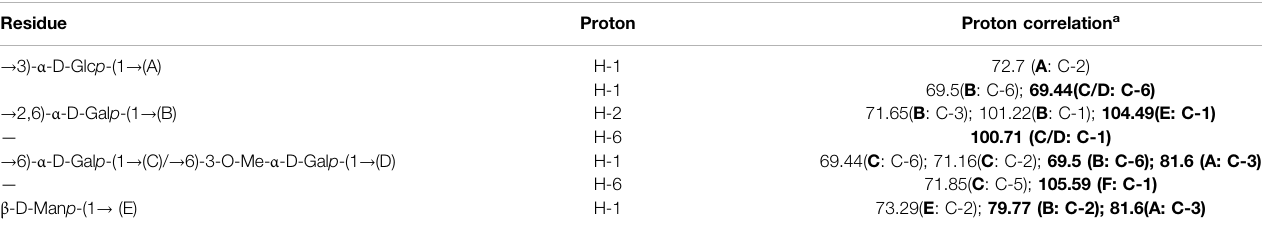
a Inter-residue correlations are shown in bold font.